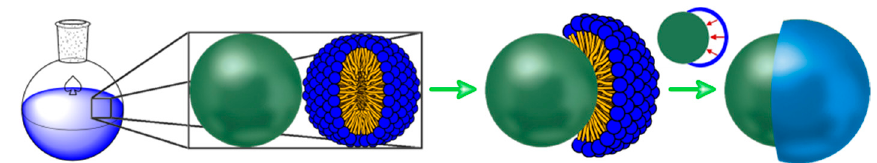
Figure 1. Schematic representation of the suggested reaction mechanism for the formation of polystyrene–polyphenylsiloxane Janus particles. The surface-active species is represented by the blue head group and orange tail. The polystyrene particle is represented by the green sphere. The polyphenylsiloxane patch is represented by the blue patch.